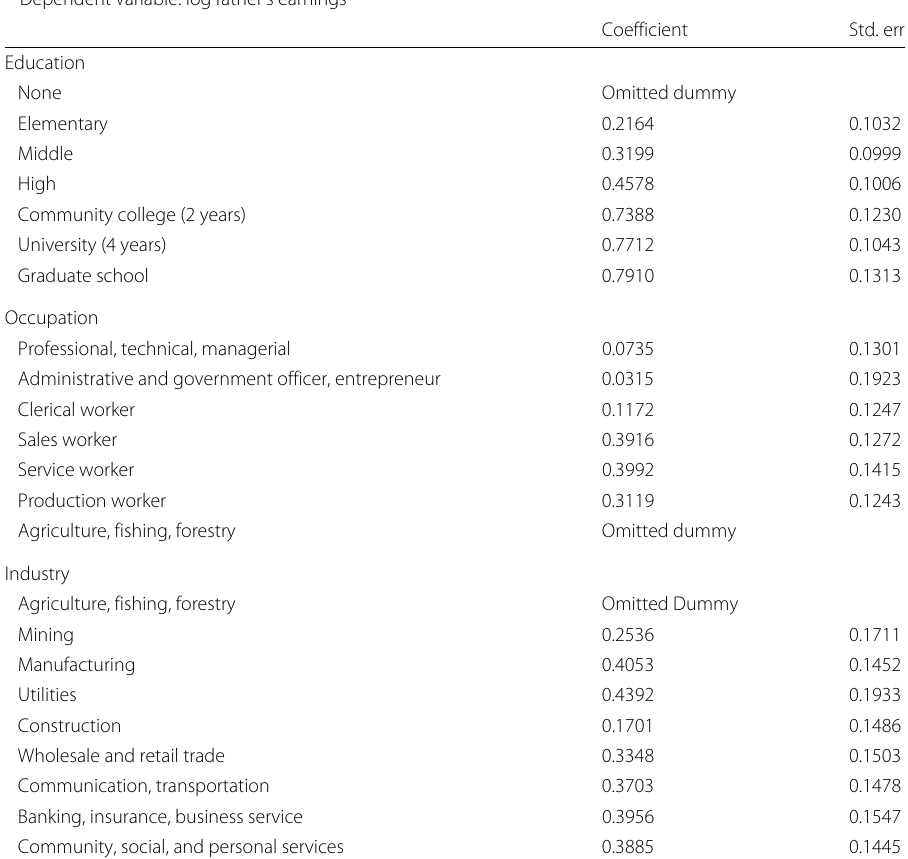
Dependent variable: log father’s